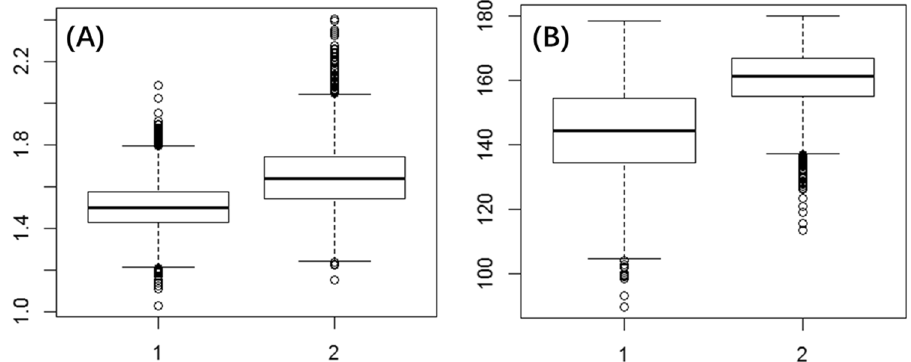
Figure 6. The one-way ANOVA test between RS complexes of kumamolisin-As and Kuma030. ( A ) distance r(O S … H D ) comparison; ( B ) a(O S … H D -O D ) comparison. Sample 1 is Kuma030 and Sample 2 is kumamolisin-As. 5000 windows were obtained based on 500 ps QM/MM MD